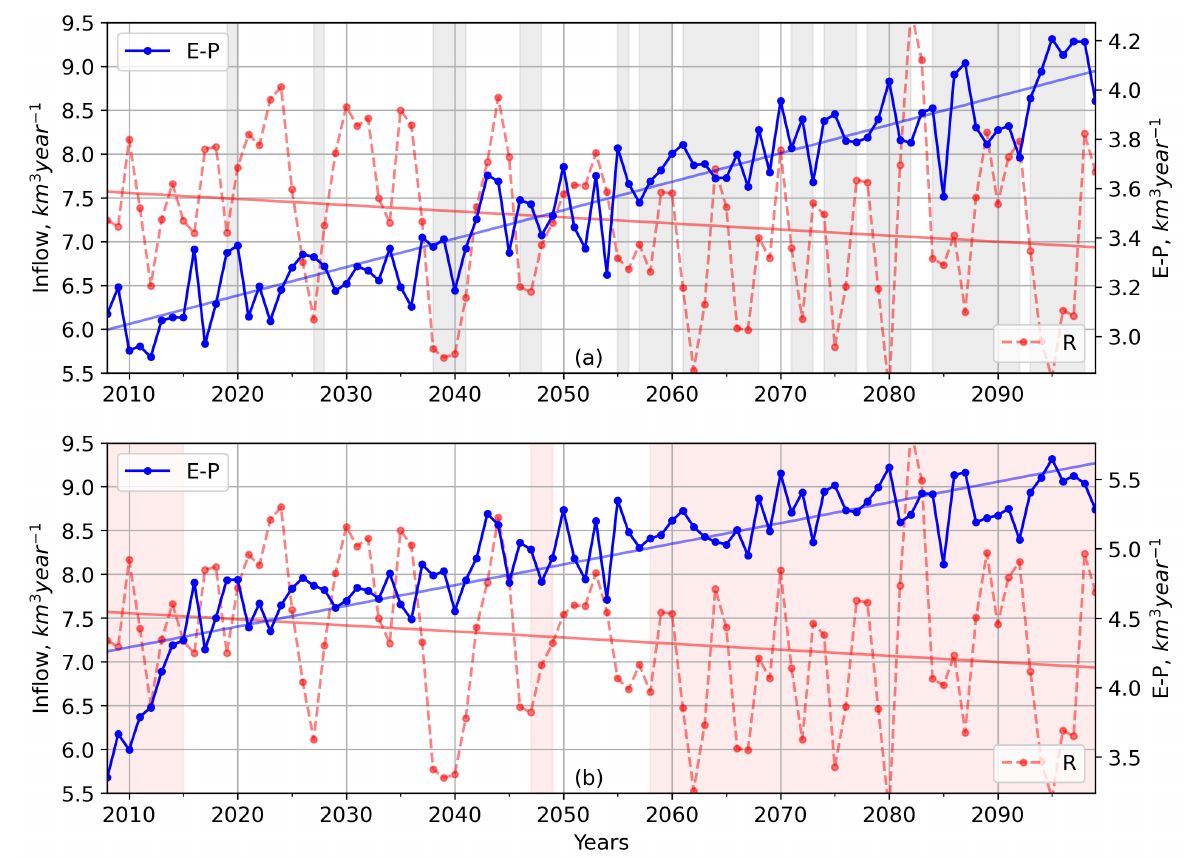
Figure 9. Annual values of river inflow (red line) and evaporation minus precipitation (blue line) according to mean modeling results under RCP 8.5 scenario for present dam height ( a ) and increased dam height ( b ). The gray-filled area on panel ( a ) refers to the periods of unstable (V < 26.5 km 3 ) lake volume conditions in the case of present dam height; the red-filled area on panel ( b ) refers to the periods of lake volume decreasing (V < 48 km 3 ) in the case of increased dam